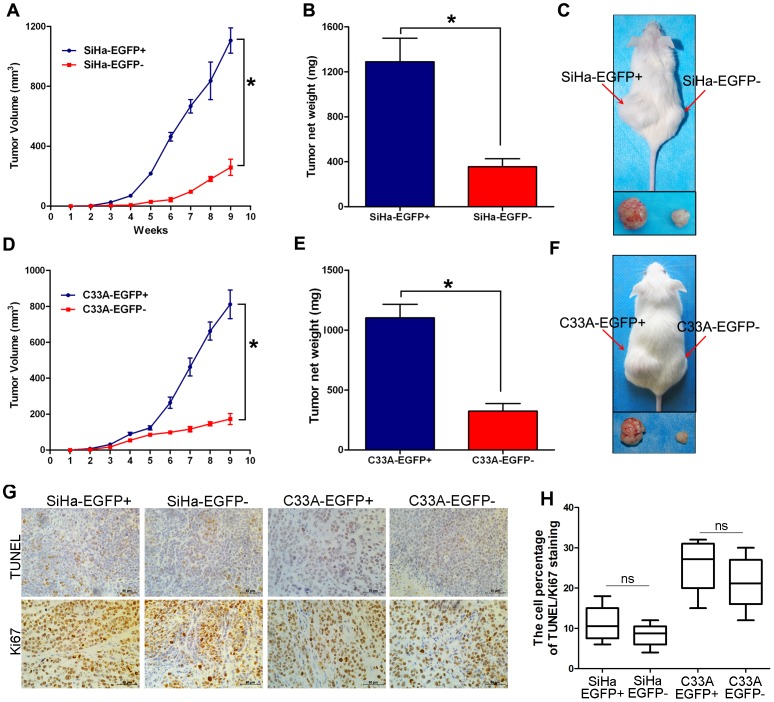
EGFP-positive cells exhibit a greater capacity for tumorigenicity than EGFP-negative cells.Tumor growth curves (A) and tumor weights (B, C) of NOD/SCID mice inoculated with SiHa-EGFP+ and SiHa-EGFP− cells (1×105 cells). Tumor growth curves (D) and tumor weights (E, F) of NOD/SCID mice inoculated with C33A-EGFP+ and C33A-EGFP− cells (1×105 cells). The apoptosis/proliferation cell rate was evaluated by Tunel assays and Ki67 staining in xenograft (G and H) of EGFP+ and EGFP- cells. Bars = SE. *, p<0.05. ns, p>0.05.